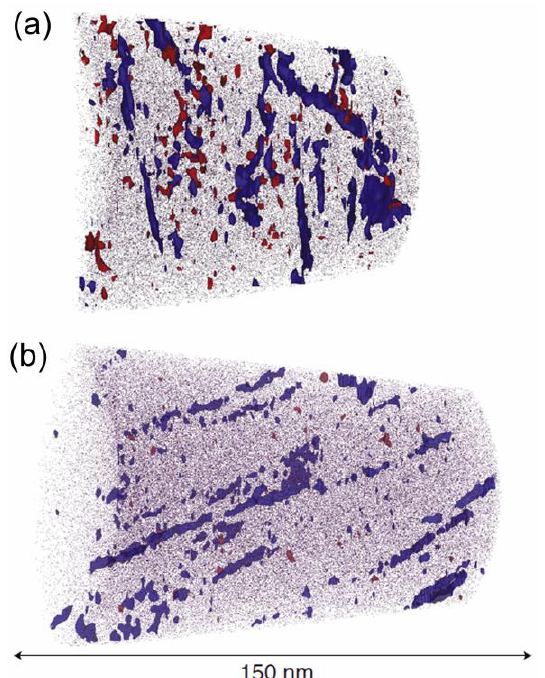
Figure 4. Atom-probe tomography reconstructions of Ti 85.5 at.% (blue) and Nb 22.8 at.% (red) for ( a ) Ti-2448. + 300 ◦ C / 4 h, and ( b ) Ti-2448 + 300 ◦ C / 8 h, with 25% of the Zr atoms displayed (purple). It can be found that the number density of Nb domains decreases with the increasing aging time. (Reproduced with permission from ref. [201]. Copyright (2016), Elsevier).